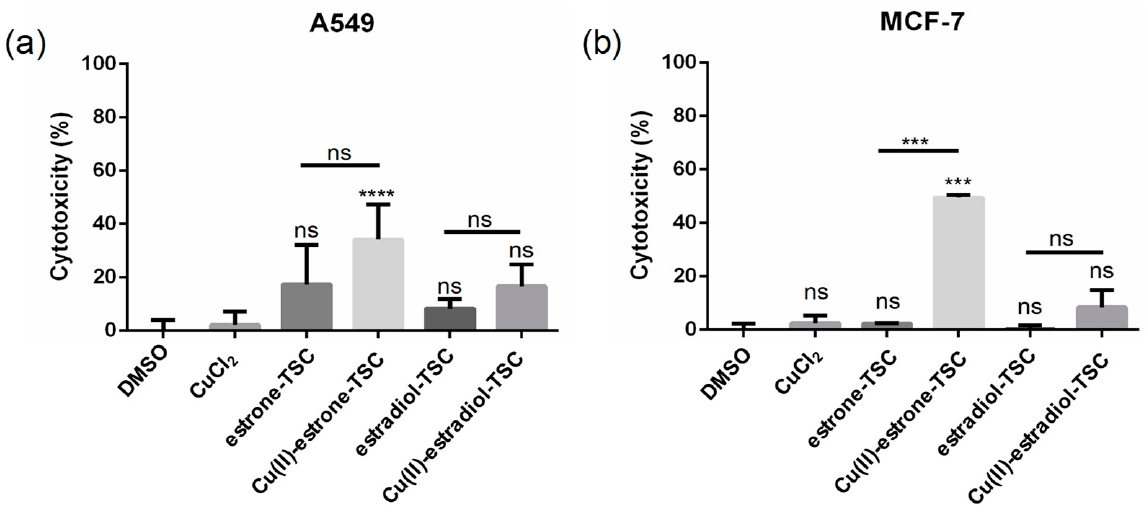
Figure 10. LDH assay to measure the reduction in plasma membrane integrity: cytotoxicity (%) obtained on ( a ) A549 and ( b ) MCF-7 cells upon the treatment with estrone-TSC and estradiol-TSC and their Cu(II) complexes (20 µ M) in addition to the DMSO blank (90% DMSO and 10% phosphate buffered saline (PBS)) and CuCl 2 (20 µ M), as indicated in the figure using 24 h incubation time. (ns: not-significant; ***: p < 0.005; ****: p < 0.001).